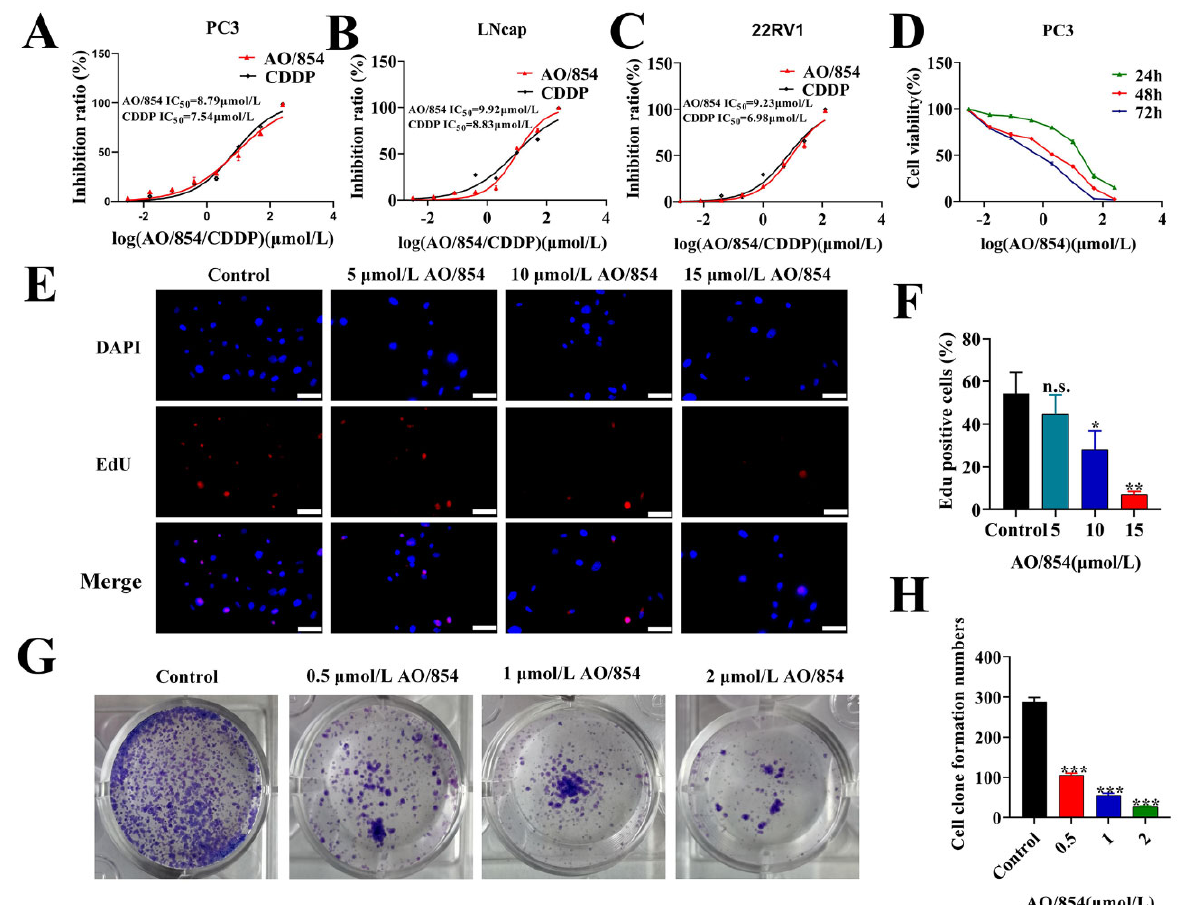
Figure 4. AO/854 repressed proliferation in prostate cancer cells. ( A – C ) Inhibition ratios in prostate cancer cells following 48 h treatment: for PC3 cells, AO/854 IC 50 —8.79 μ mol/L and CDDP IC 50 ‐ 7.54 μ mol/L ( A ); for LNcap cells, AO/854 IC 50 —9.92 μ mol/L and CDDP IC 50 —8.83 μ mol/L ( B ); and for 22RV1 cells, AO/854 IC 50 —9.23 μ mol/L and CDDP IC 50 —6.98 μ mol/L ( C ). ( D ) Inhibitory effects of AO/854 on cell viability of PC3 cells. ( E ) Inhibitory effects of AO/854 on the proliferative activity of PC3 cells by the EdU assay. Scale bars: 50 µ m. ( F ) Quantification of EdU experiments in AO/854 (5, 10, 15 µ mol/L)-treated groups compared with DMSO-treated group (control group). Data represent the average of three independent experiments. Error bars: SD. (n.s. p > 0.05, * p < 0.05, ** p < 0.01). ( G ) Inhibitory effects of AO/854 on colony formation activity of PC3 cells by colony formation assay. PC3 cells were treated with AO/854 at concentrations of 0.5, 1, and 2 µ mol/L for about 1 week. ( H ) Quantification of colony formation experiments in AO/854 (0.5, 1, 2 µ mol/L)-treated groups compared with DMSO-treated group (control group). Data represent the average of three independent experiments. Error bars: SD. (*** p <